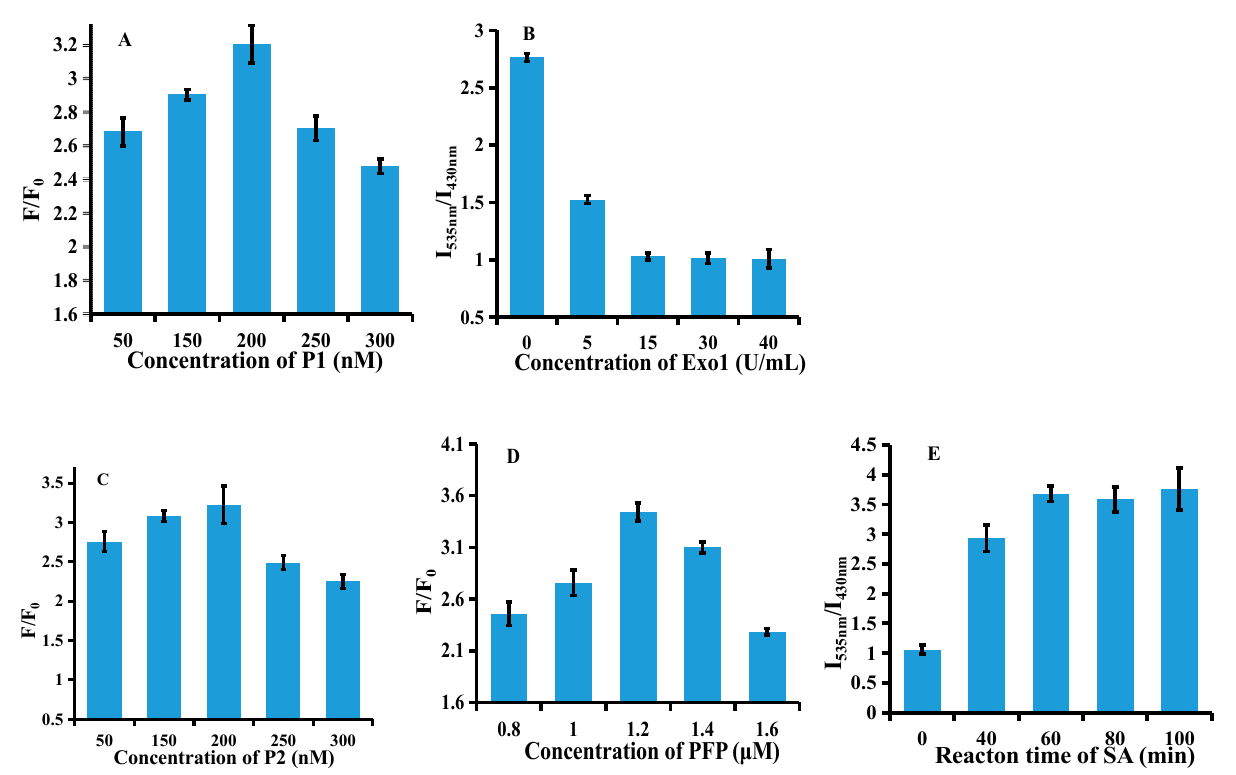
Figure 2. Optimization of experimental conditions. ( A ) concentrations of P1 (50, 150, 200, 250, 300 nM); ( B ) concentrations of Exo I (0, 5, 15, 30, 40 U/mL); ( C ) concentration of P2 (50, 150, 200, 250, 300 nM); ( D ) concentrations of PFP (0.8, 1, 1.2, 1.4, 1.6 µM); ( E ) SA reaction time (0, 40, 60, 80, 100 min).